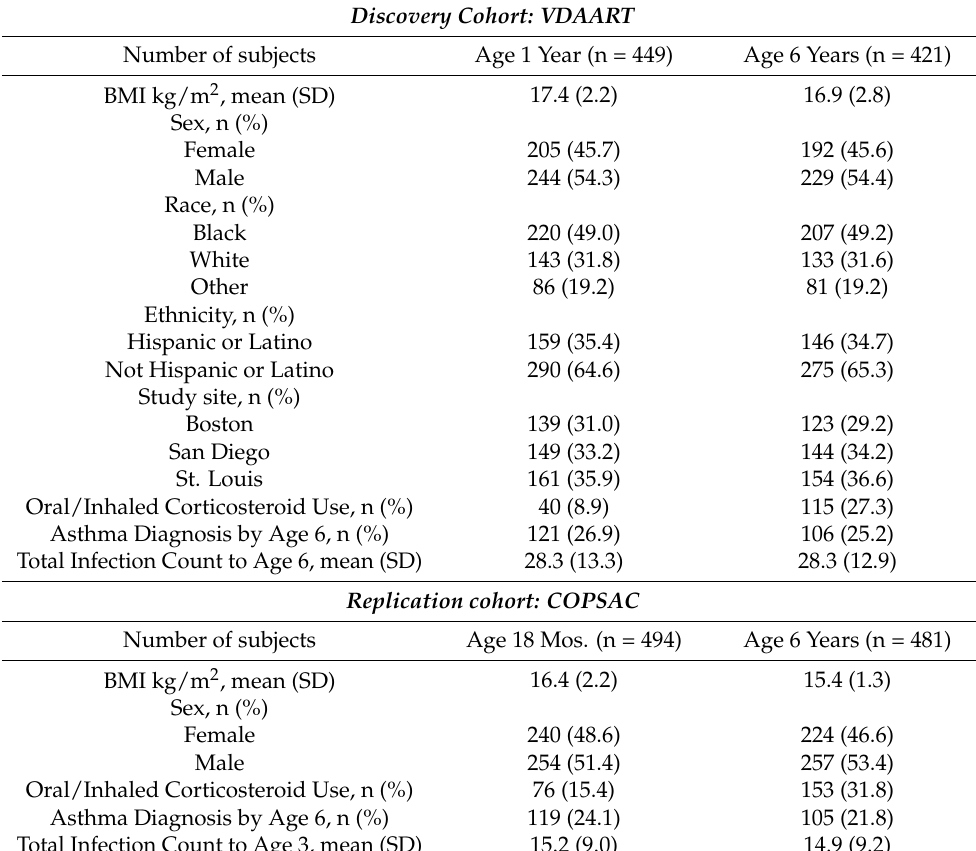
Table 1. Demographic and clinical characteristics of child study participants in the VDAART discov- ery population and COPSAC replication